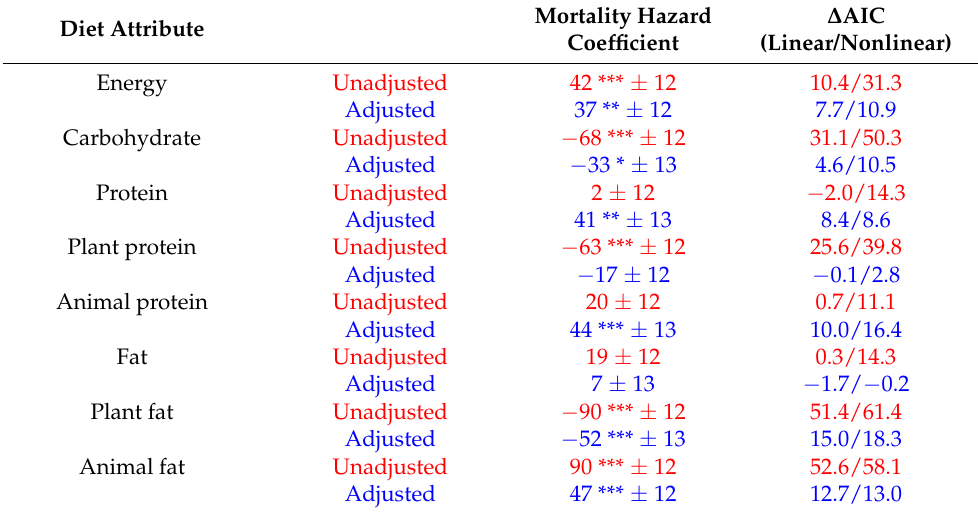
Table 2. Diet associations with